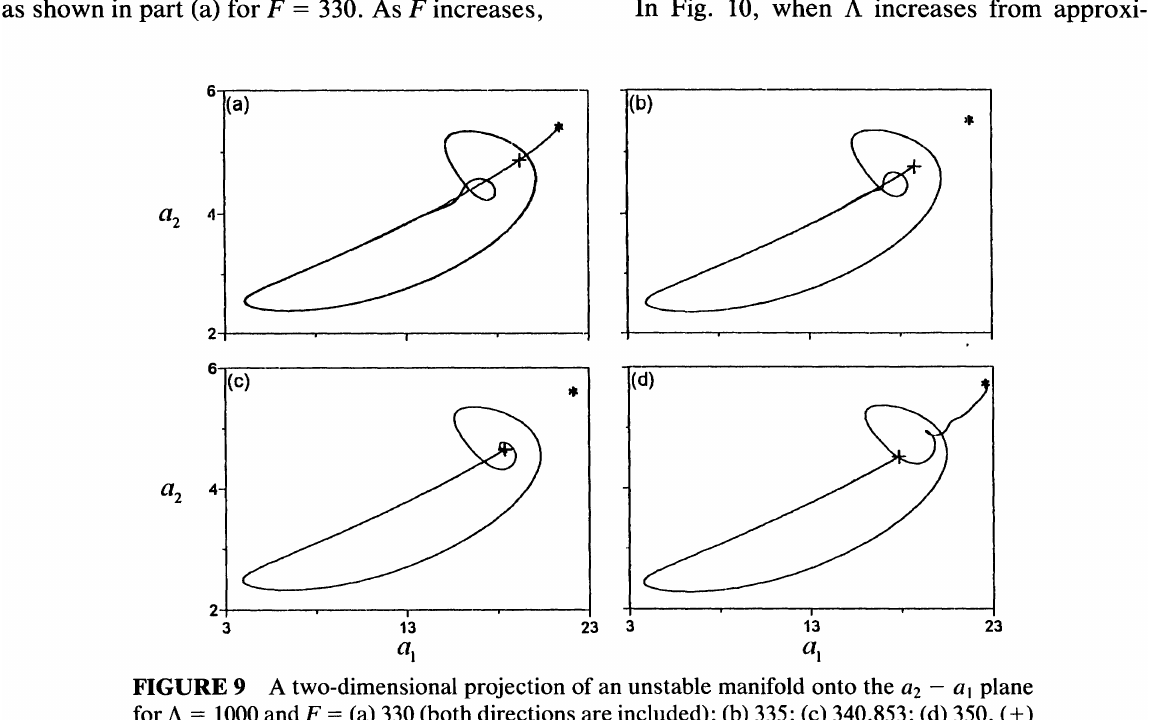
FIGURE 9 A two-dimensional projection of an unstable manifold onto the a2 - al plane for A = 1000 and F = (a) 330 (both directions are included); (b) 335; (c) 340.853; (d) 350. (+) denotes a saddle and (*) denotes a